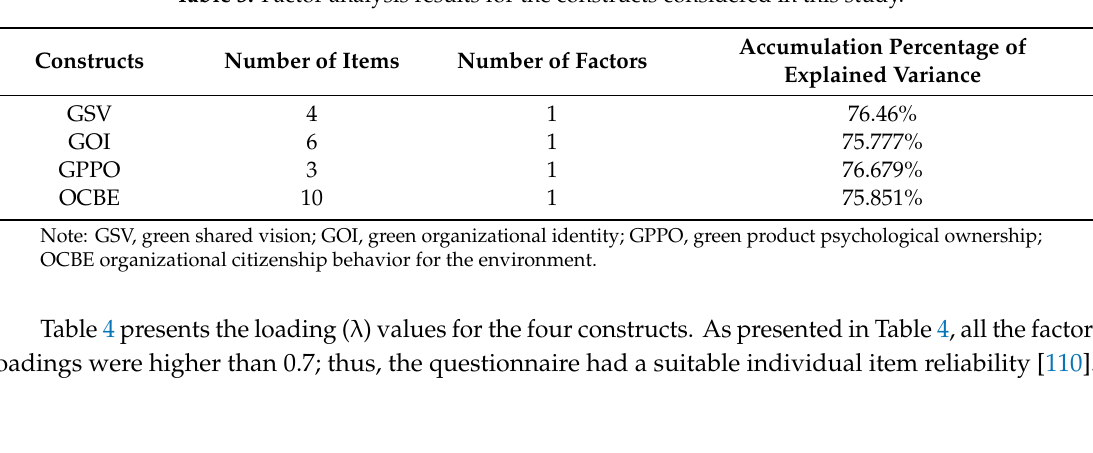
Table 3. Factor analysis results for the constructs considered in this